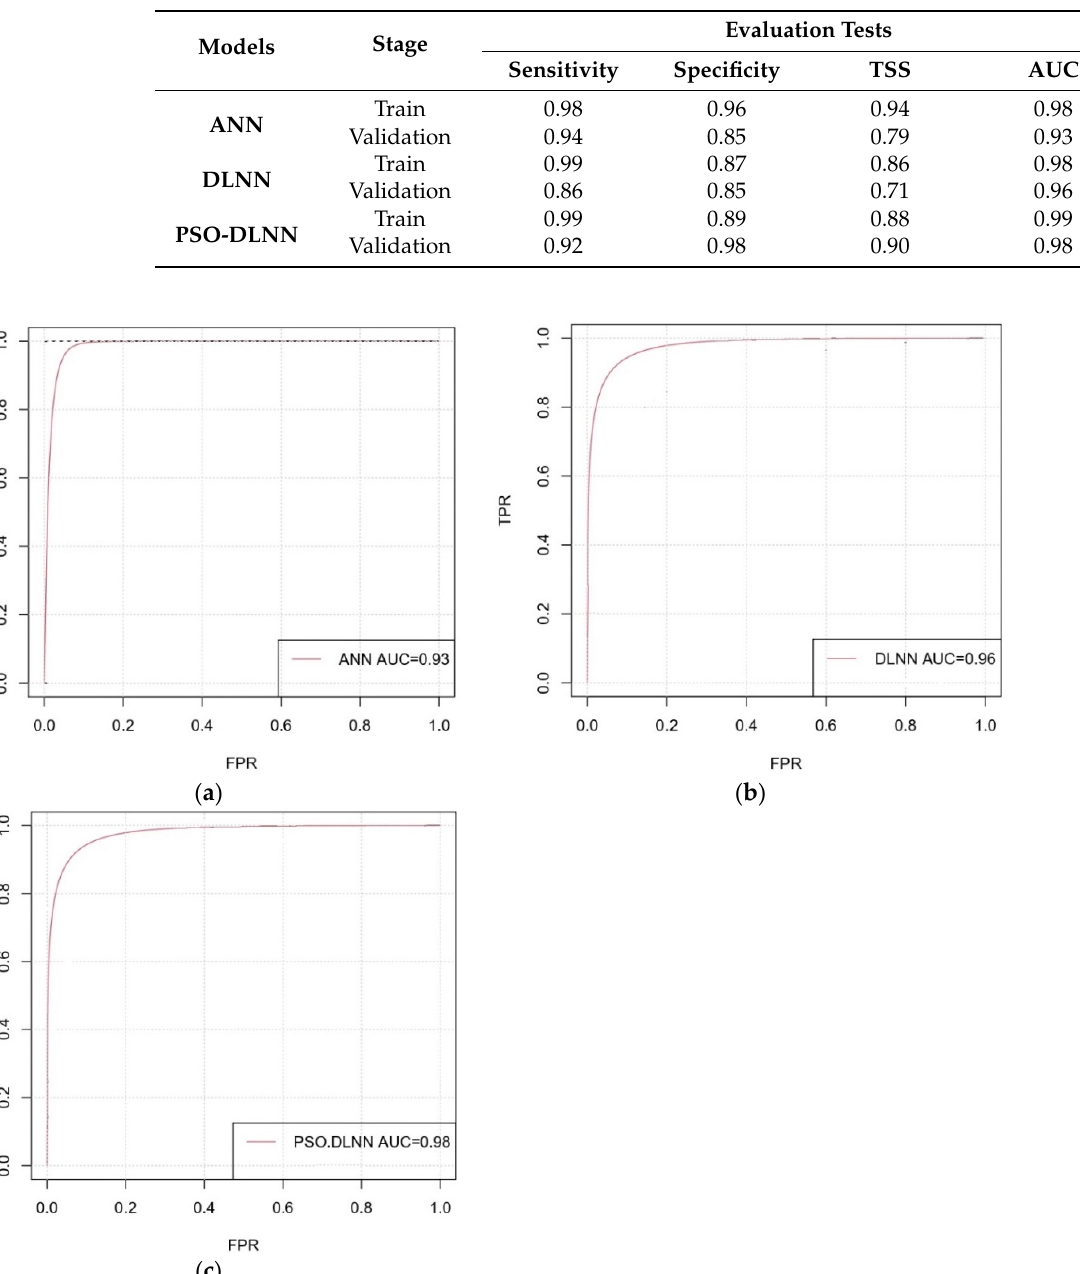
Table 6. Predictive capability of ANN, DLNN, and PSO-DLNN models using train and test dataset.